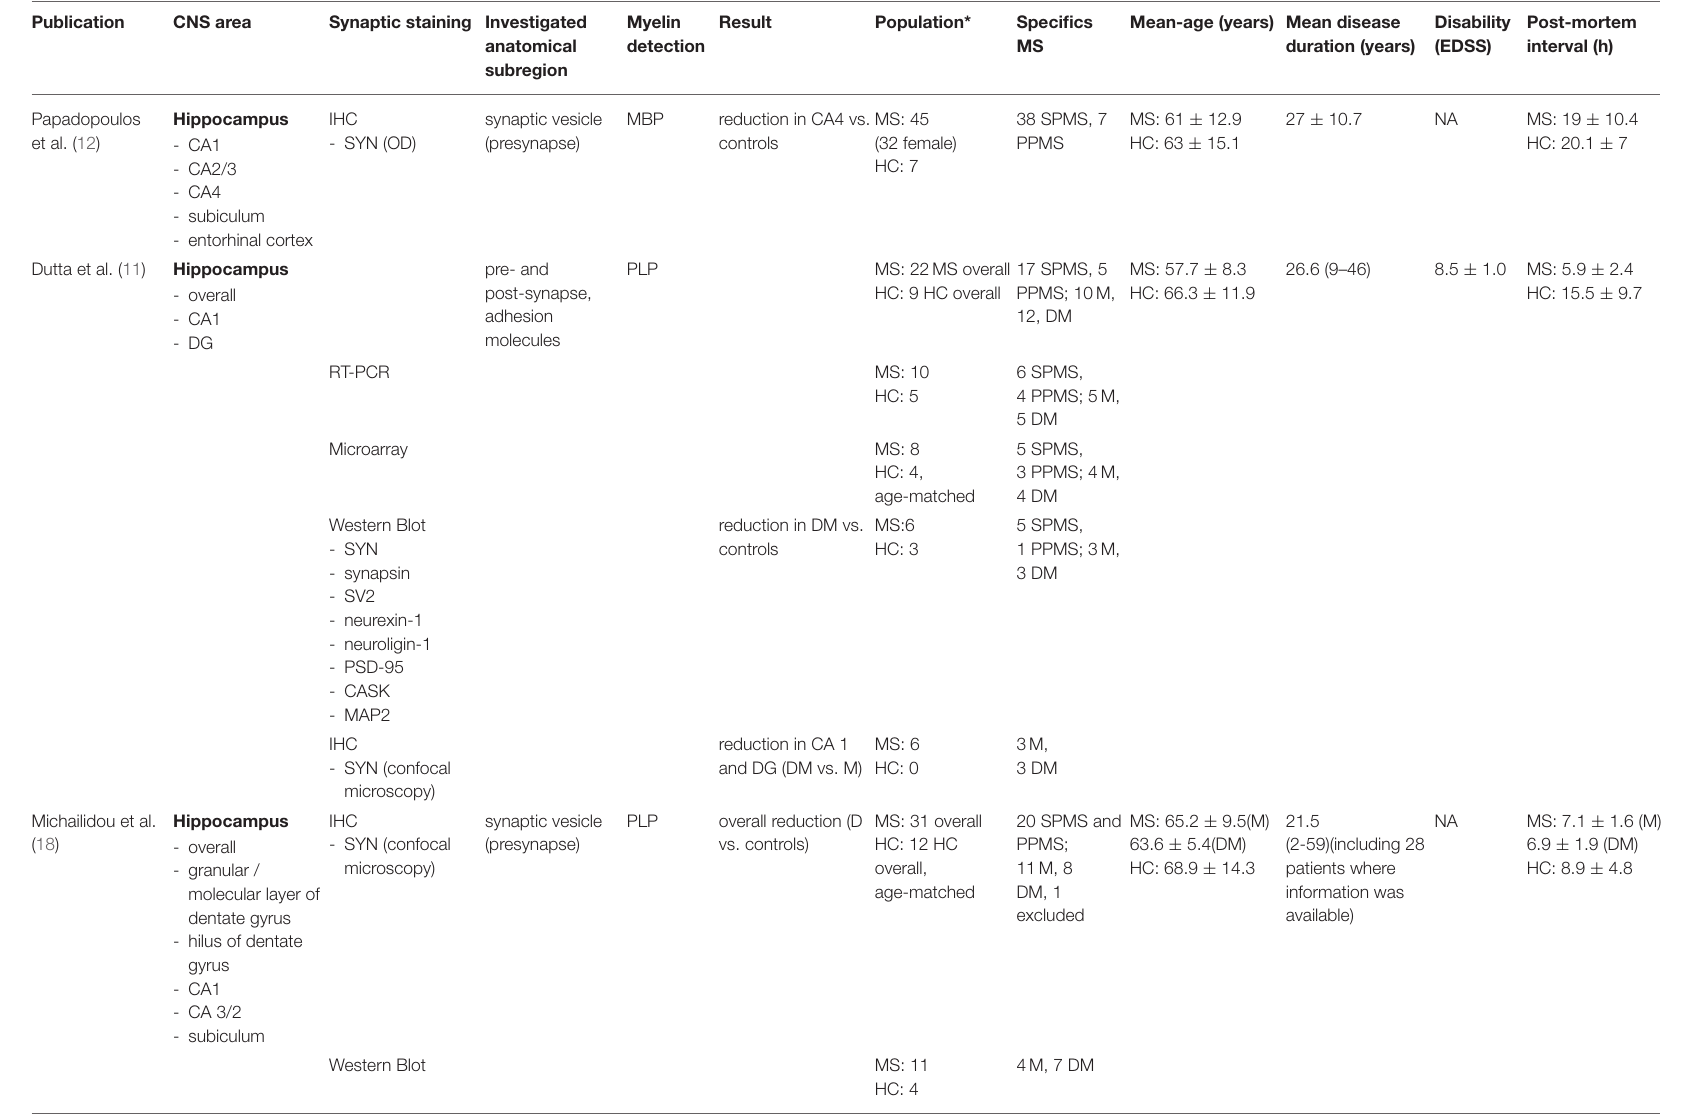
TABLE 2 | An overview of publications that investigated the synaptic density in the hippocampus along with extracted